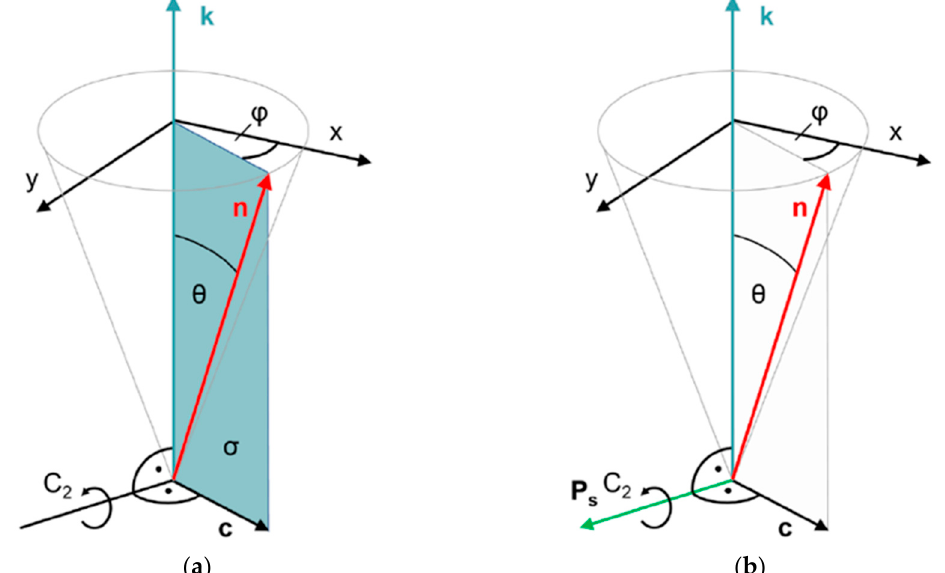
Figure 2. Symmetries of ( a ) smectic C (SmC) and ( b ) chiral smectic C (SmC*) liquid crystals. The director n is tilted with respect to the smectic layer normal k by the tilt angle 𝜃 . The tilt direction is indicated by the c director and specified by the azimuth angle 𝜑 . The directions of k and n define the tilt plane. Normal to the tilt plane, we find a twofold symmetry axis C 2 , since the directions of + n and + k are physically equivalent to the directions of – n and – k , respectively. In addition, the tilt plane is a mirror plane in the case of non-chiral SmC. Both symmetry elements combine to the non-polar point group C 2h . In the presence of chiral molecules, however, mirror symmetry is expelled and the C 2 axis remains the only symmetry element. Thus, the chiral SmC* phase has polar C 2 symmetry, and a spontaneous polarization vector P s along the C 2 axis is allowed by symmetry.